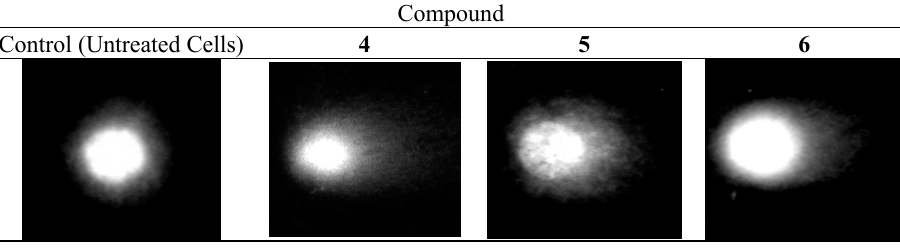
Figure 6. DNA comets obtained from MCF-7 cells treated for 24 h with 4 – 6 (single-cell electrophoresis).